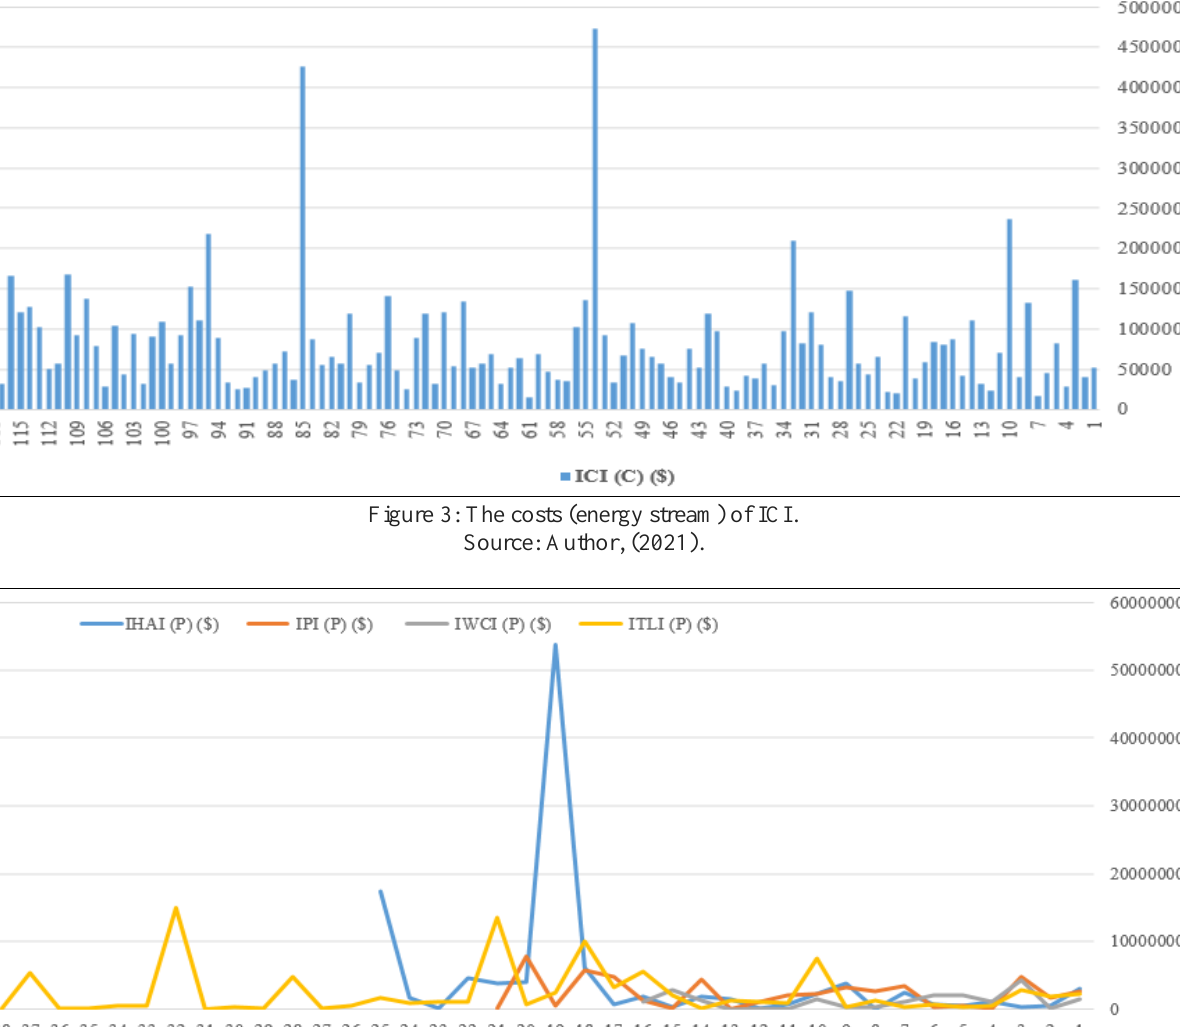
Figure 4: The revenue of industrial